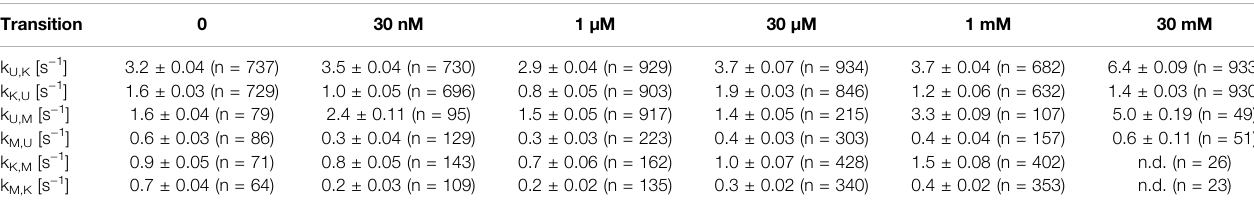
TABLE 2 | Transition rates derived from dwell time fi ts at various Gdm + concentrations at 1 mM Mg 2+ .